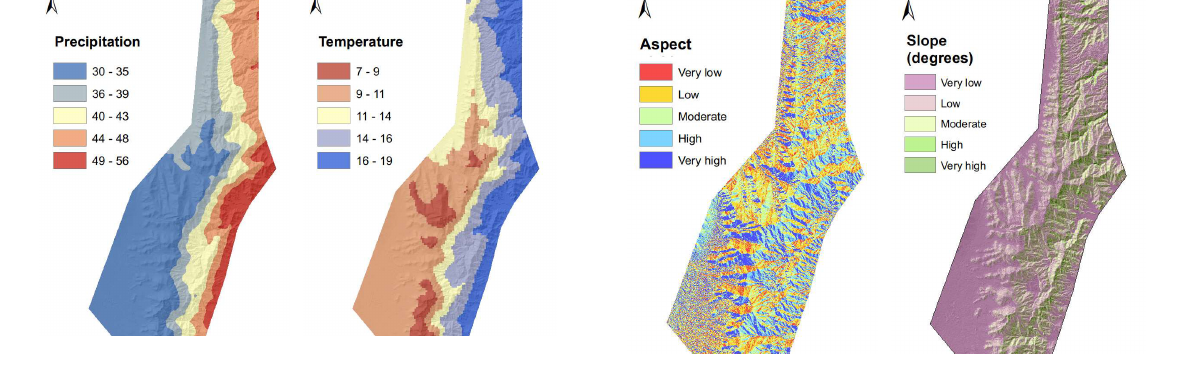
Figure 4. Weighted maps of aspect and slope